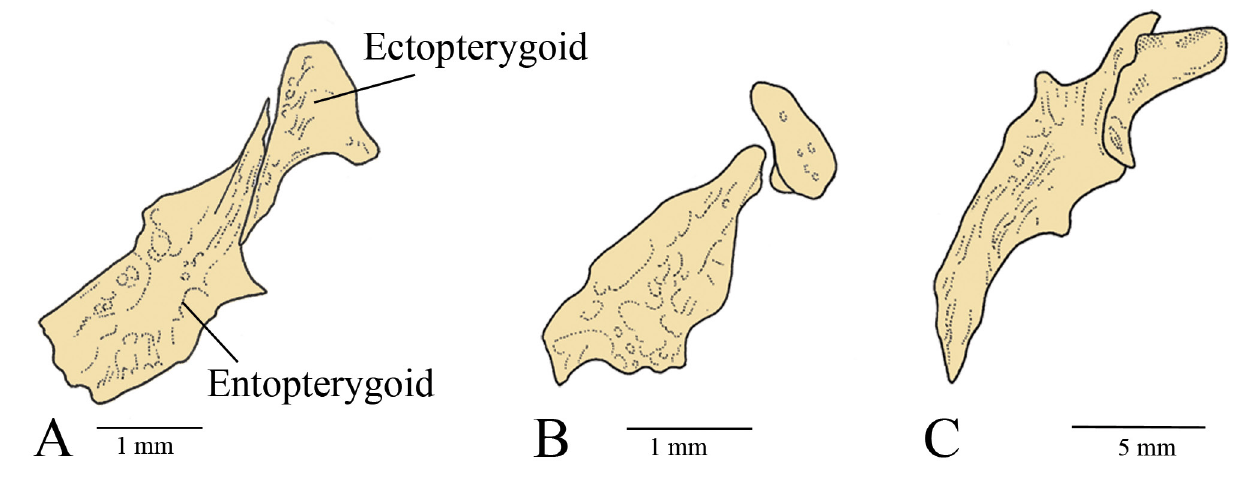
FIGURE 6 | Ventral view of left ectopterygoid and entopterygoid bones; anterior up: A. Batrochoglanis raninus , MZUSP 23407; B. Lophiosilurus albomarginatus , ROM 61336; C. Lophiosilurus alexandri , MZUEL